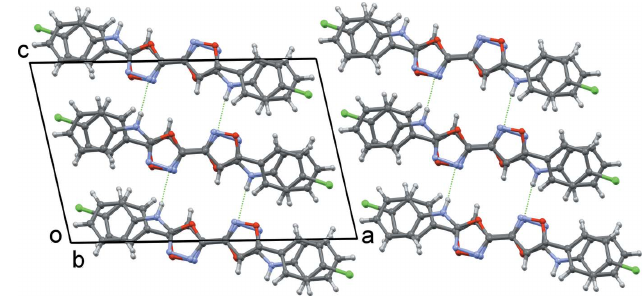
Figure 2 A segment of the crystal structure showing N—H (cid:3)(cid:3)(cid:3) N hydrogen bonds as dotted lines.